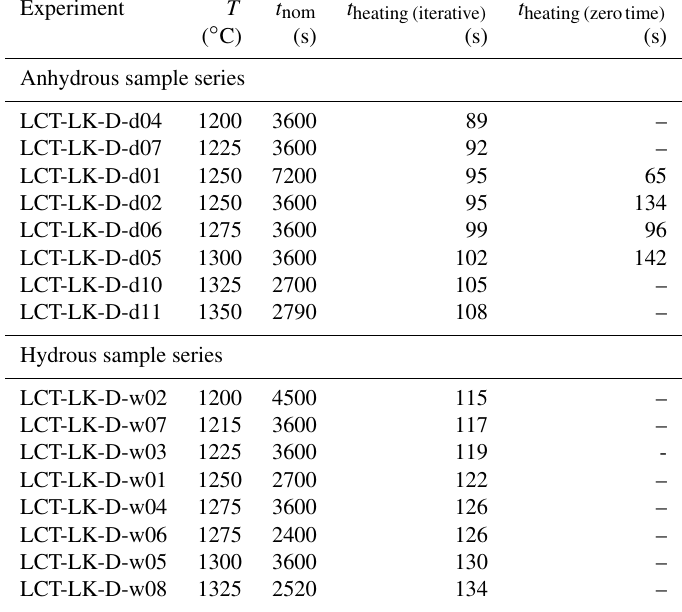
Table 4. Determined diffusion times of the IHPV heating